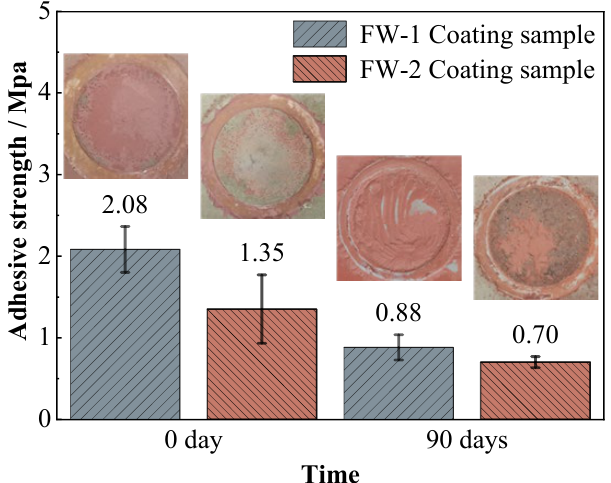
Figure 13. Adhesion results of two coating samples before and after the immersion test.